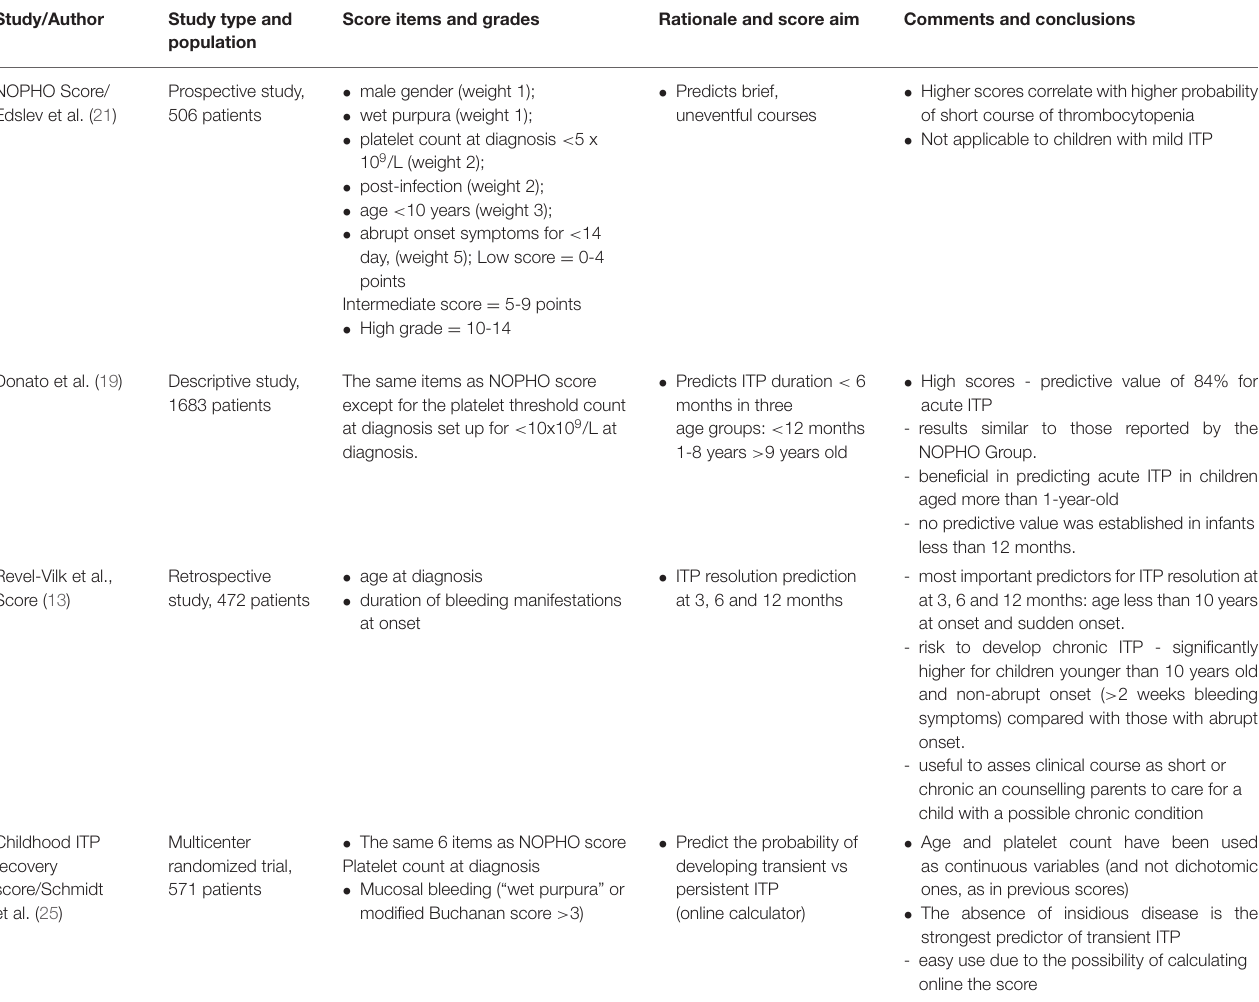
TABLE 2 | Summary of the main predictive clinical